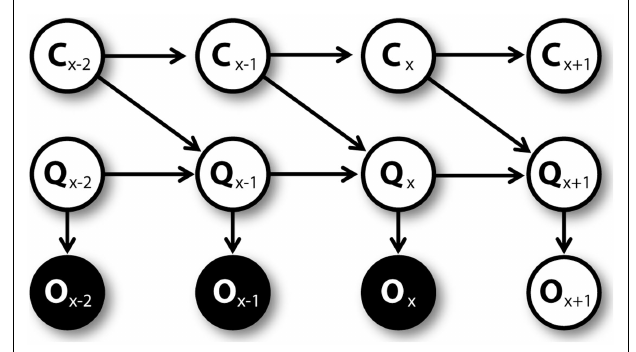
FIGURE 4 | Graphical model for learning C and Q values,